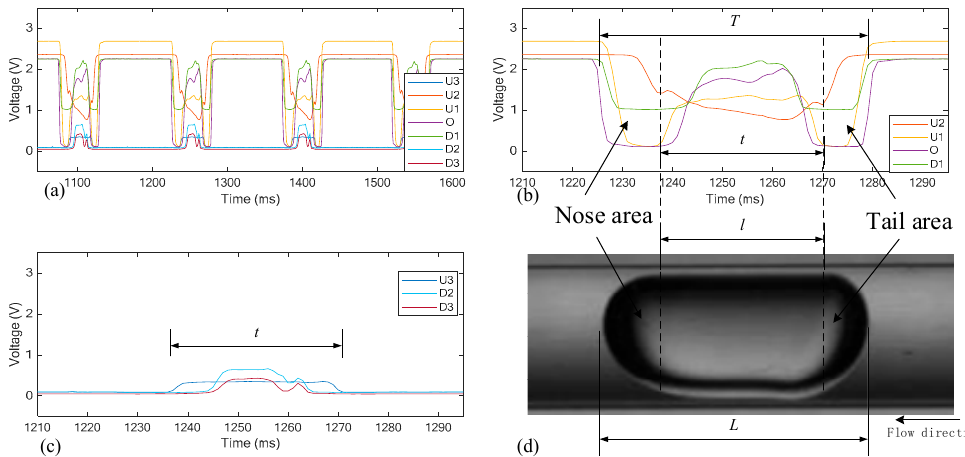
Figure 4. Optical signals of the vertical array: ( a ) optical signals of the vertical array; ( b ) signals of U2, U1, O, and D1; ( c ) signals of unit U3, D2, and D3; ( d ) flipped image of a single slug.